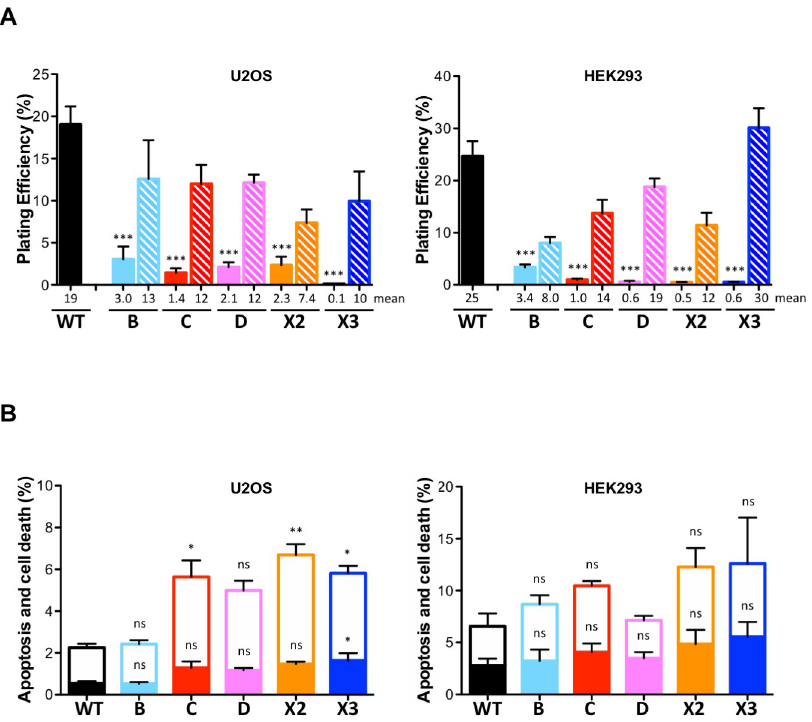
Fig 2. RAD51 paralog disruption in human U2OS and HEK293 cells leads to reduced plating efficiency but not to apoptosis. (A) Plating efficiency analysis was determined by colony formation assay normalized to initial seeding density. Filled and hatched bars are the mutant cells and the mutant cells stably complemented with a retroviral construct expressing the corresponding wild-type allele, respectively. Results are presented as means +/- SD from three experiments. Differences between mutant and wild-type cells were statistically analyzed using unpaired one-way ANOVA and Tukey’s test. � p < 0.05, �� p < 0.01, ��� p < 0.001, ns not significant. Comparisons between complemented and wild-type cells were, respectively in U2OS and HEK293, B � , C � , D � , X2 ��� , and X3 ��� ; and B ��� , C � , D ns , X2 �� , and X3 ns (not indicated in the figure). Comparisons between complemented and mutant cells were, respectively in U2OS and HEK293, B ��� , C ��� , D ��� , X2 ns and X3 ��� ; and B ns , C �� , D ��� , X2 � and X3 ��� (not indicated in the figure). (B) Apoptosis and cell death analysis using Annexin V and 7-Aminoactinomycin D staining of RAD51 paralog knockout cells. Open and filled bars represent fractions of dead cells and apoptotic cells, respectively. Results are presented as means +/- SD from three experiments. Differences between mutant and wild-type cells were statistically analyzed using unpaired one-way ANOVA and Tukey’s test. � p < 0.05, �� p < 0.01, ns not